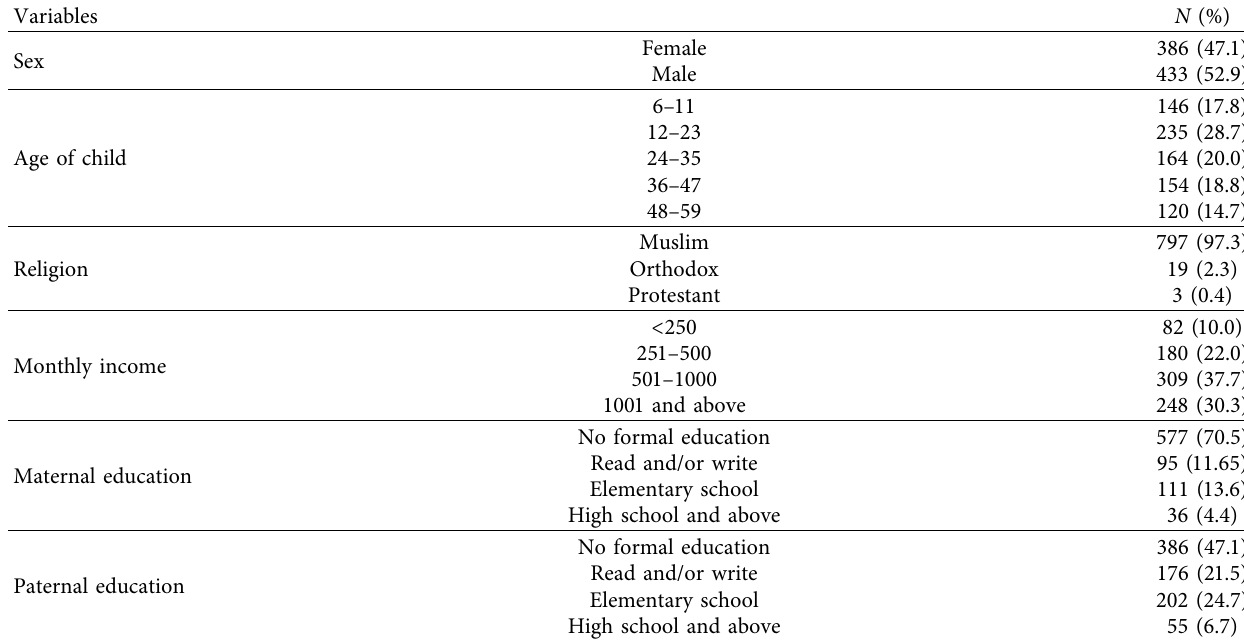
Table 1: Sociodemographic characteristics of the study participants from Lanfro District, Silte Zone, Southern Ethiopia, 2016 ( n � 819).